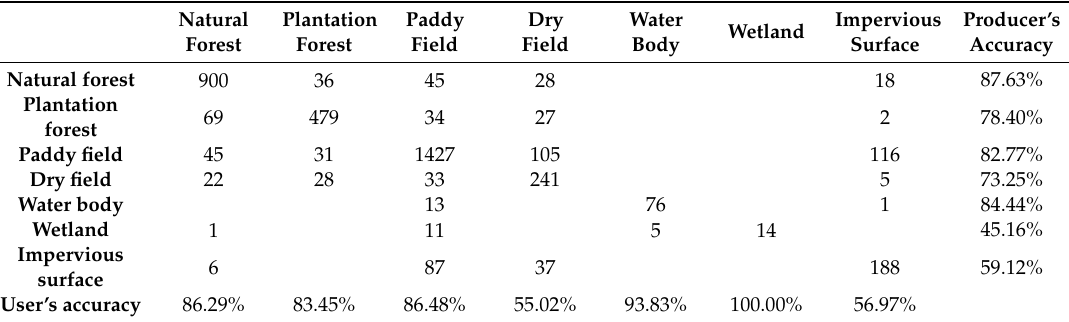
Table 2. Confusion matrix for SB